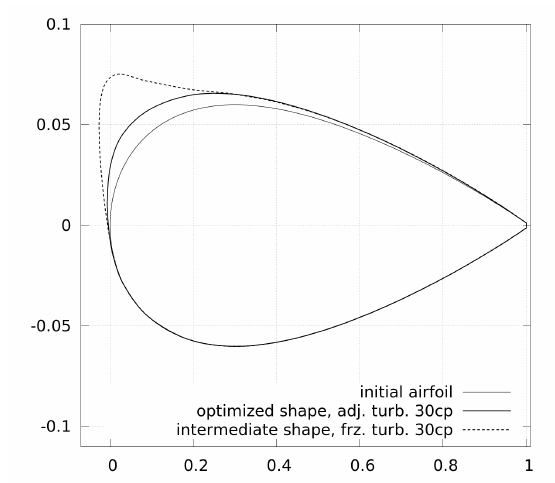
Figure 12. Intermediate airfoil shape during an optimization of lift at AoA = 12 ◦ using frozen turbulence compared to the initial airfoil and the final shape using adjoint turbulence (all with 30 control